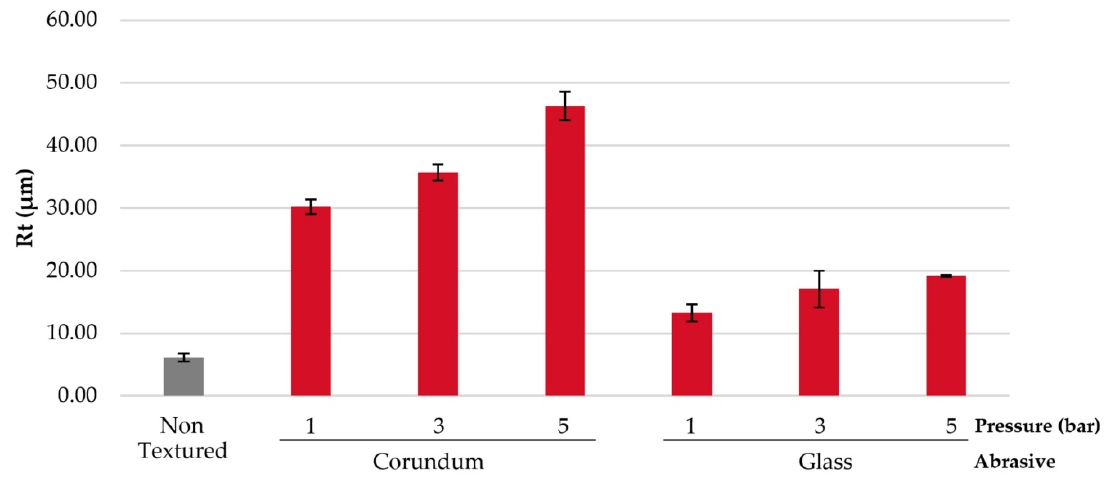
Figure 6. Rt values obtained in blasting tests.